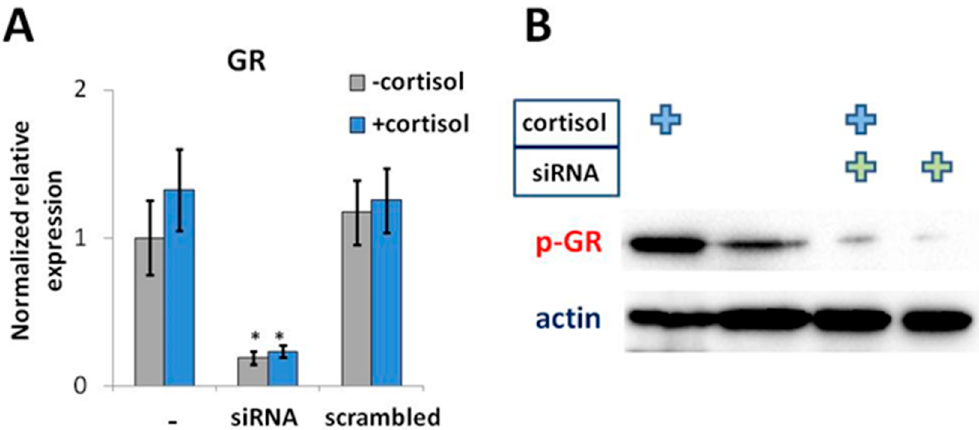
Figure 2. Cortisol-mediated activation promotes hyperphosphorylation of GR in NCIH-196 lung cancer cells. Stimulation by cortisol (50 ng/mL, 24 h) did not influence the level of GR expression ( A ) but resulted in elevated levels of phosphorylated GR protein ( B ). “siRNA” and “scrambled” indicate transfection with specific siRNA or control scrambled siRNA, respectively. Real-time PCR data was obtained using the ∆∆ Ct approach, normalized to β -actin and represented as Mean ± SEM (five independent experiments). * p < 0.01. Western blot data is a representative image of three replicate experiments.